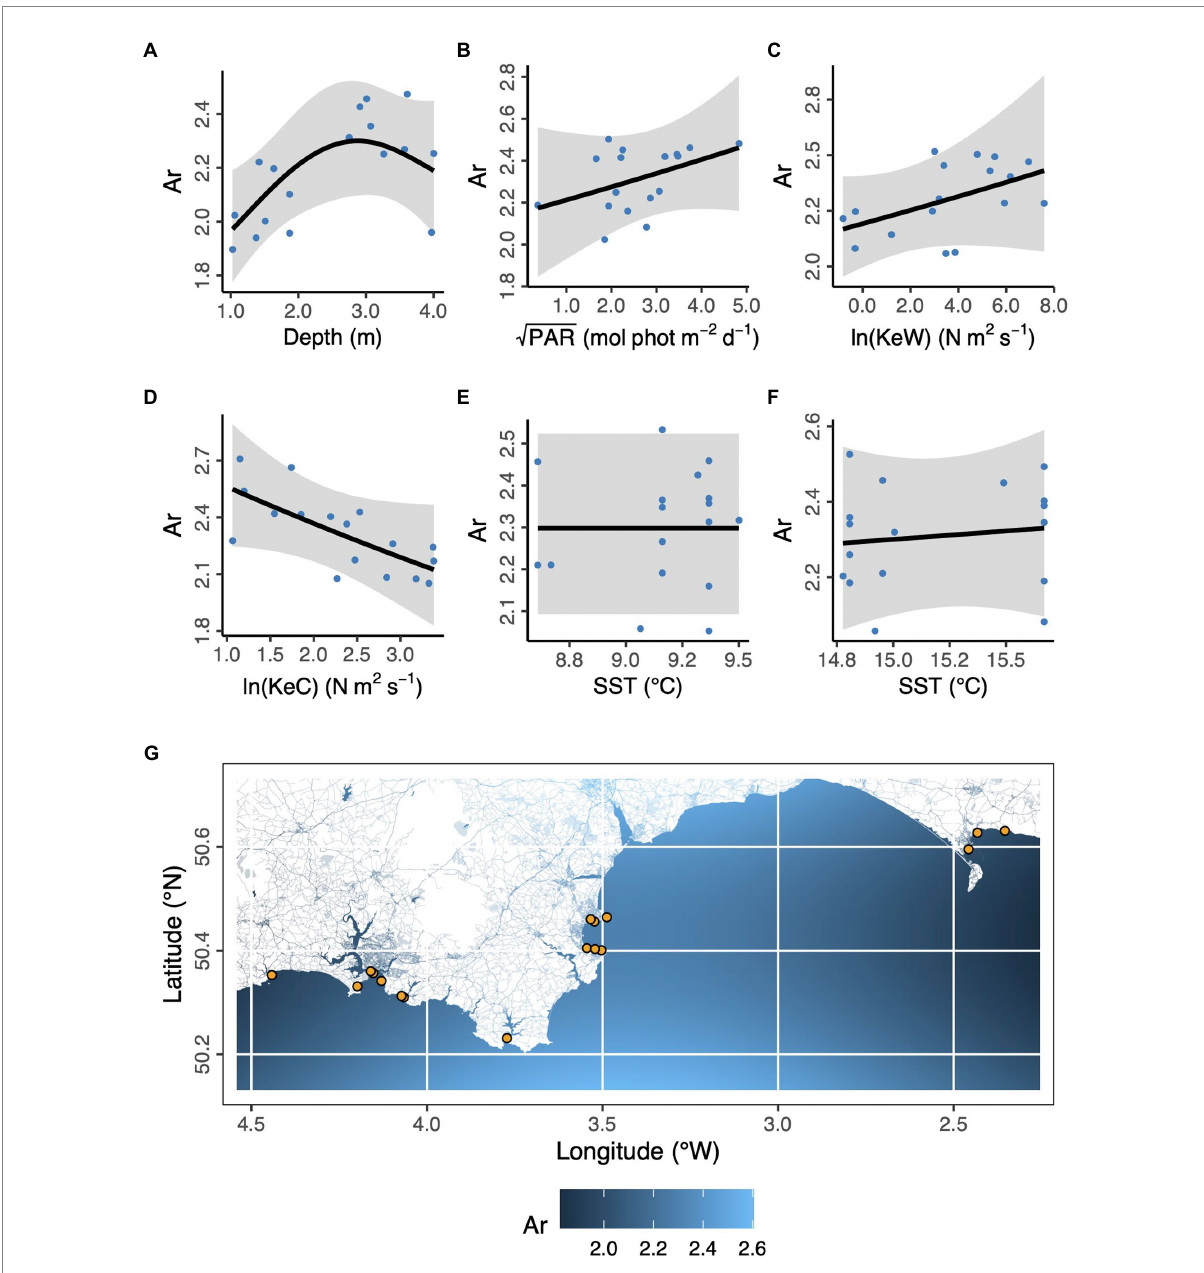
FIGURE 3 Environmental and geographical predictors of Zostera marina allelic richness, Ar, at 17 locations (orange points in panel G ) across the south coast of England. (A) Depth is below chart datum. (B) PAR is photosynthetically active radiation at the seabed. KeW (C) and KeC (D) are kinetic energy, associated with waves and currents, respectively. SST is sea surface temperature in March (E) and August (F) 2016. Shaded ribbons show 95% confidence intervals and blue points are partial residuals. (G) The background color scheme represents fitted estimates of Ar in geographic space. Empirical values are shown in Table